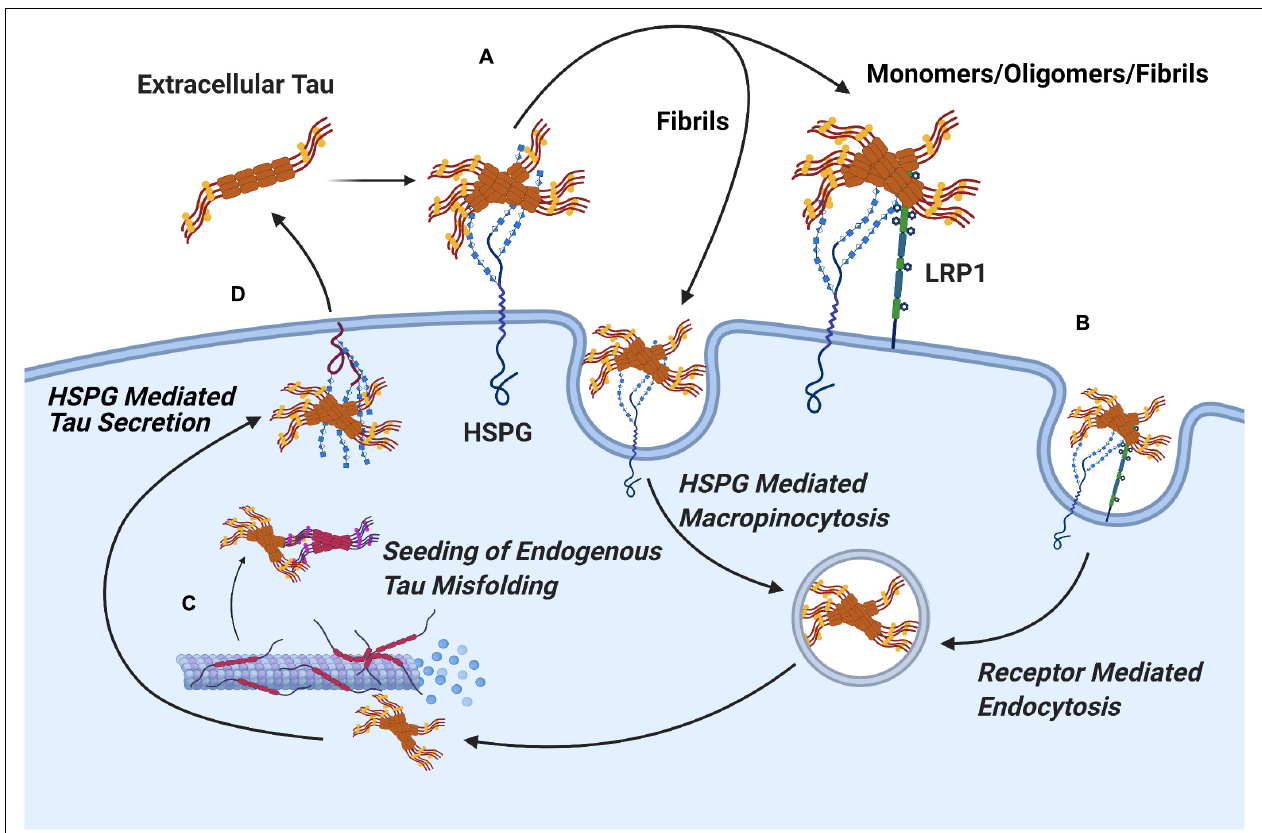
FIGURE 7 | Pathways of HSPG Mediated Secretion and Uptake of Tau Protein. (A) The binding of tau aggregates to cell surface Heparan Sulfate is a crucial, initial stage in the cellular uptake of tau in both receptor mediated and receptor independent uptake of tau. (B) Mature tau fibrils readily undergo receptor independent uptake via HSPG mediated pinocytosis, while uptake of tau monomers and oligomers proceeds via receptor mediated endocytosis through the HSPG dependent receptor LRP1. (C) Upon uptake, extracellular tau oligomers nucleate the phosphorylation and aggregation of endogenous tau protein through template misfolding. (D) Interactions between tau oligomers and HSPGs mediate vesicle free secretion of misfolded tau through a poorly understood mechanism.